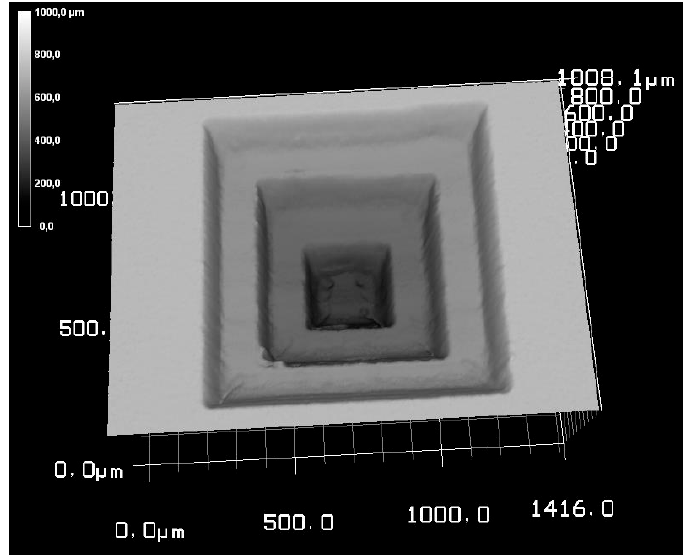
Figure 6. Laser scanning microscope image of a fiber laser micro machined inverse pyramid in AlN.